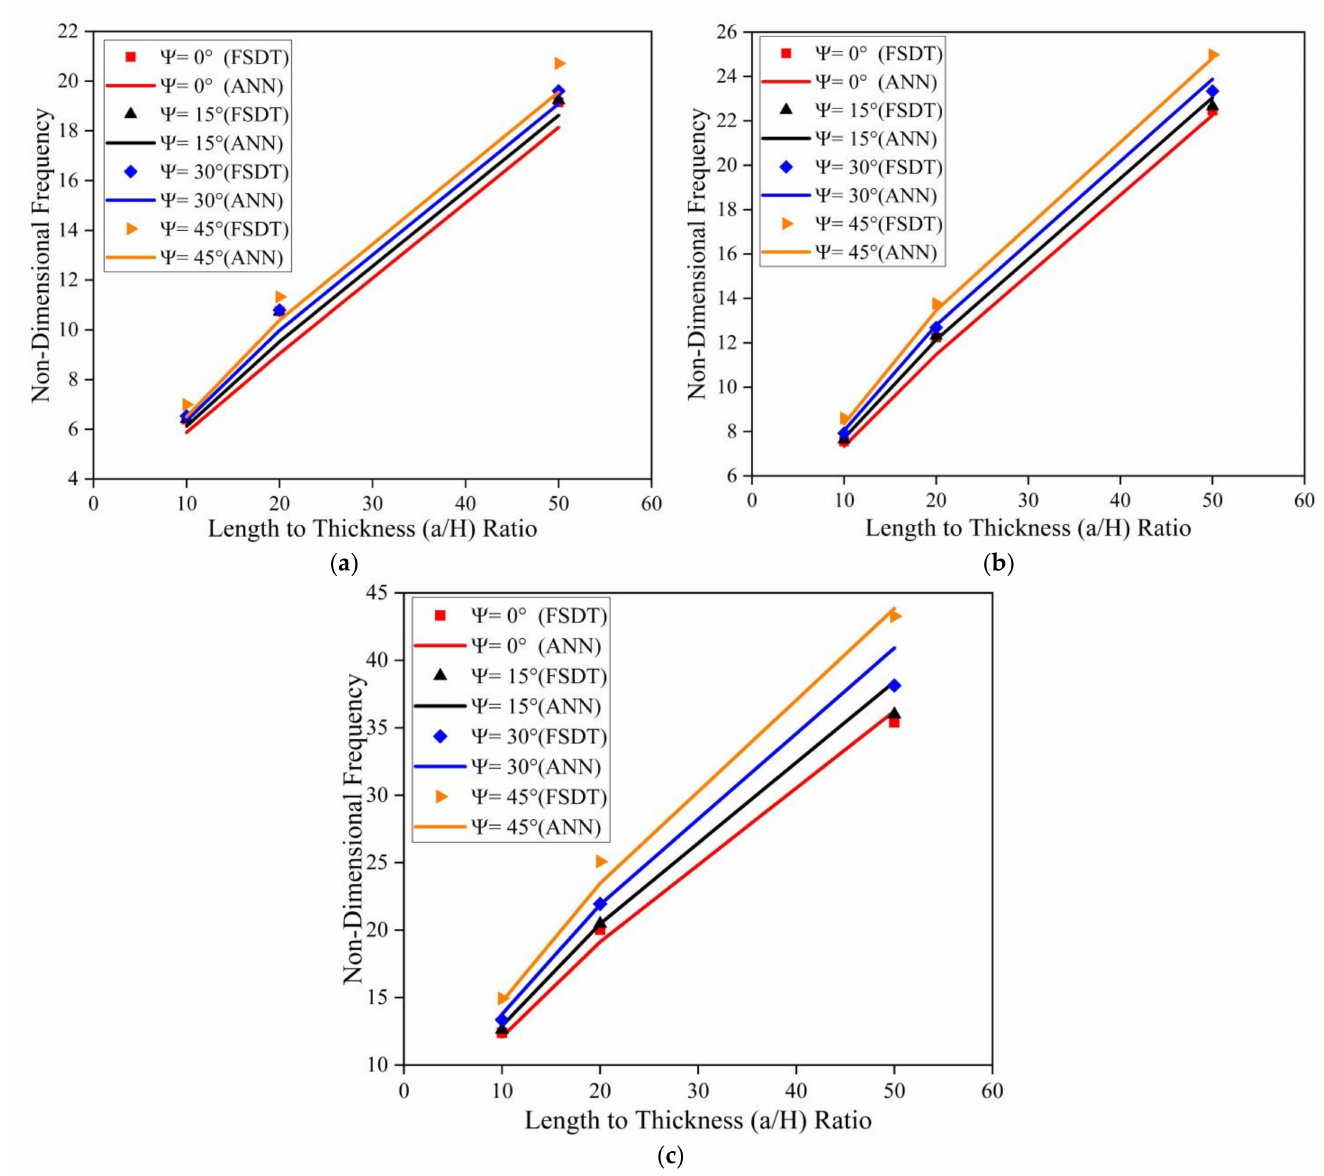
Figure 13. Influence of skew angle on the CCCC skew LCS plate in the presence of moisture (0.25%) for varying a/b and a/H ratios ( a ) a / b = 0.5 ( b ) a / b = 1.0 ( c ) a / b =